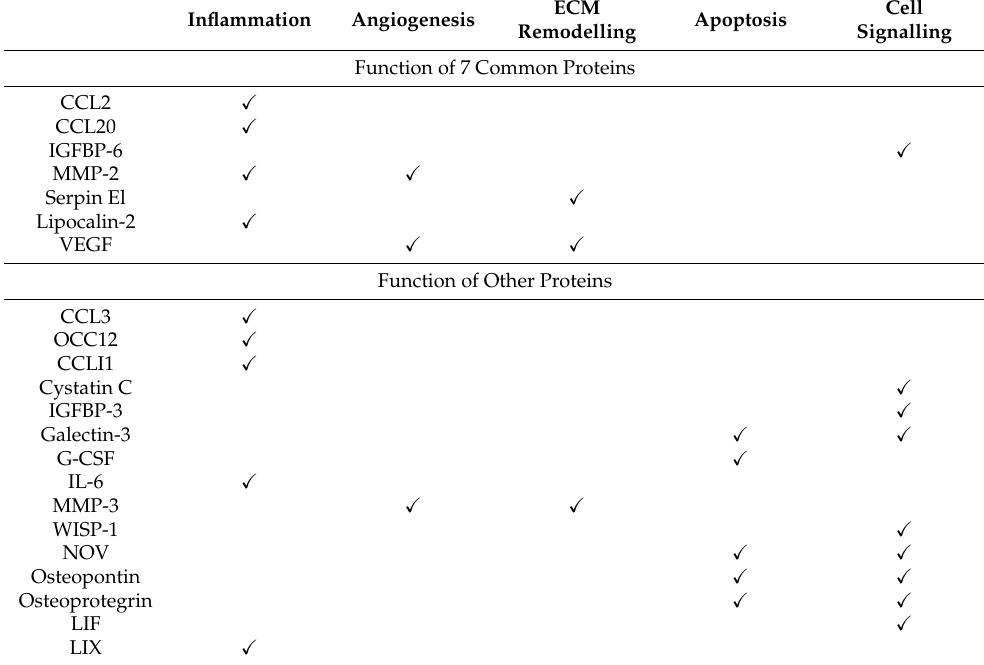
Table 1. List of proteins detected in the supernatants of MSCs. The upper section details the seven common proteins that existed in both NF3-treated and un-treated supernatant. The lower section details the 15 unique proteins detected only in NF3-treated supernatant. Their functions are related to inflammation, angiogenesis, ECM remodeling, apoptosis, and cell signaling. In terms of cell signaling, this includes cell adhesion, signal transduction, migration, proliferation, differentiation, senescence, etc. ECM Cell Inflammation Angiogenesis Apoptosis Remodelling Signalling Function of 7 Common Proteins